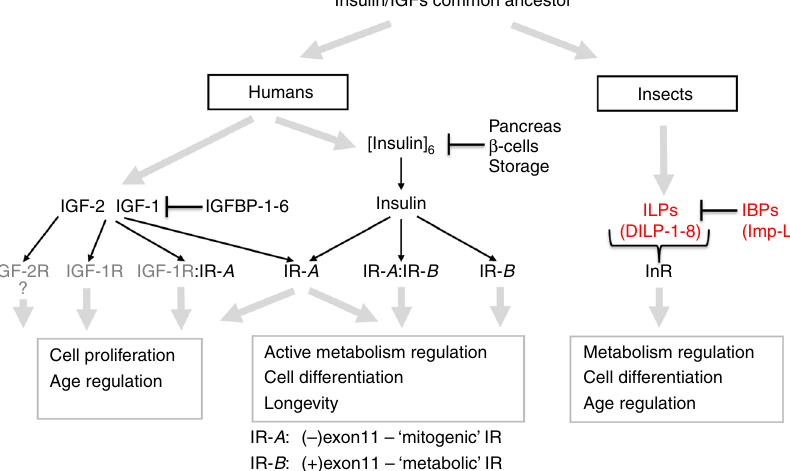
Fig. 1 The main molecular steps in the insulin/IGF axes. IR-A, IR-B isoforms of the insulin receptor (IR), IGF-1R IGF receptor, and their heterodimers, IGF-2R IGF-2 receptor, IGFBP IGF-binding proteins, IBP ILP-binding proteins, [insulin] 6 crystalline, or other oligomeric, storage form of insulin in pancreas β -cells, DILP-1-8 and Imp-L2 Drosophila ILPs and IBP,